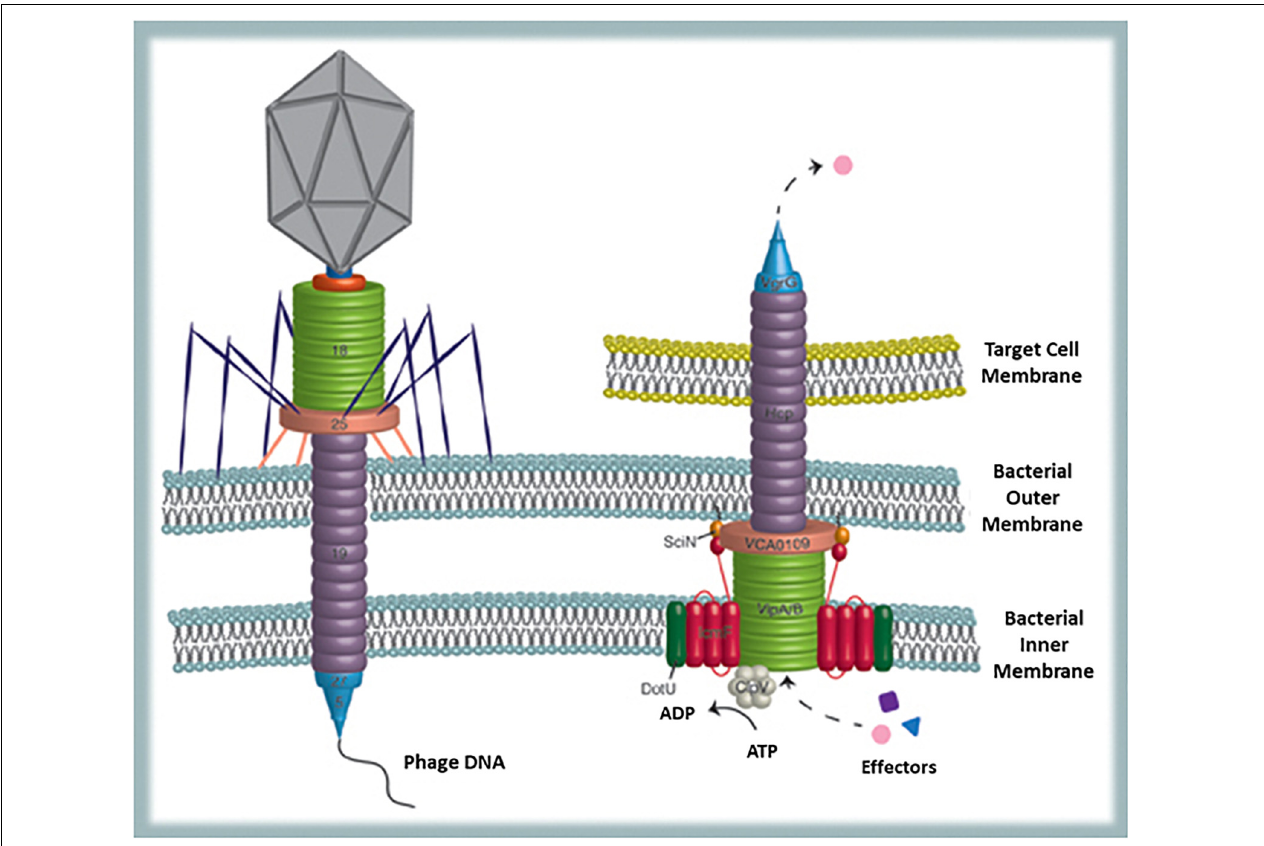
FIGURE 4 | Bacterial structures showing similarities with phages: T6SS and the phage tail.T6SS is used to translocate completely folded proteins across inner and outer membrane of the secreting bacterium and across other bacteria’s or eukaryotic host membranes (from Records,